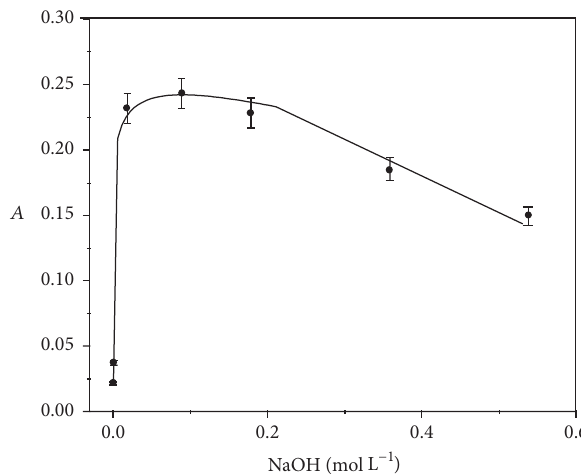
Figure 2: Effect of the temperature on the system AOF-KMnO 4 (2.3 × 10 −5 and 9.0 × 10 −4 molL −1 , resp.) with Na 2 SO 4 0.20 molL −1 , NaOH 0.30 mol L −1 , monitoring at 610 nm, and t = 30 min.